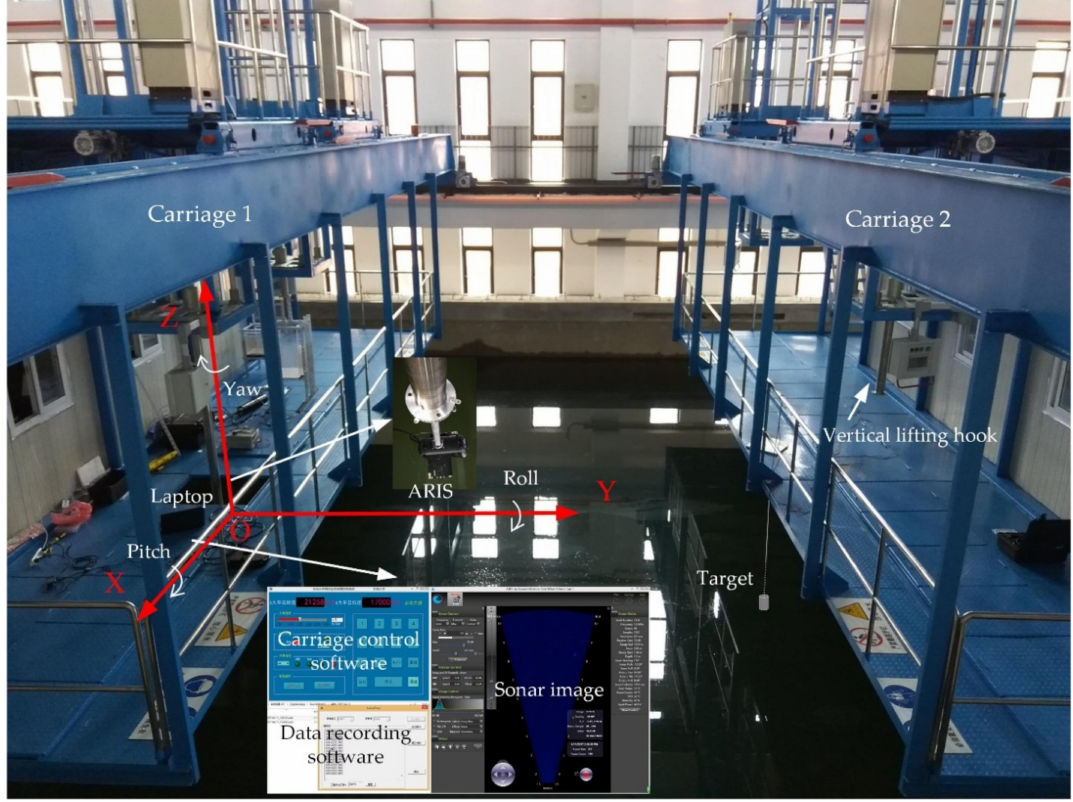
Figure 7. Photo of the indoor